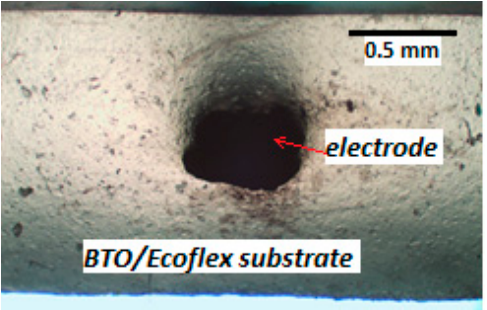
Figure 4. A cross section of the printed carbon black (CB)/Ecoflex electrode.